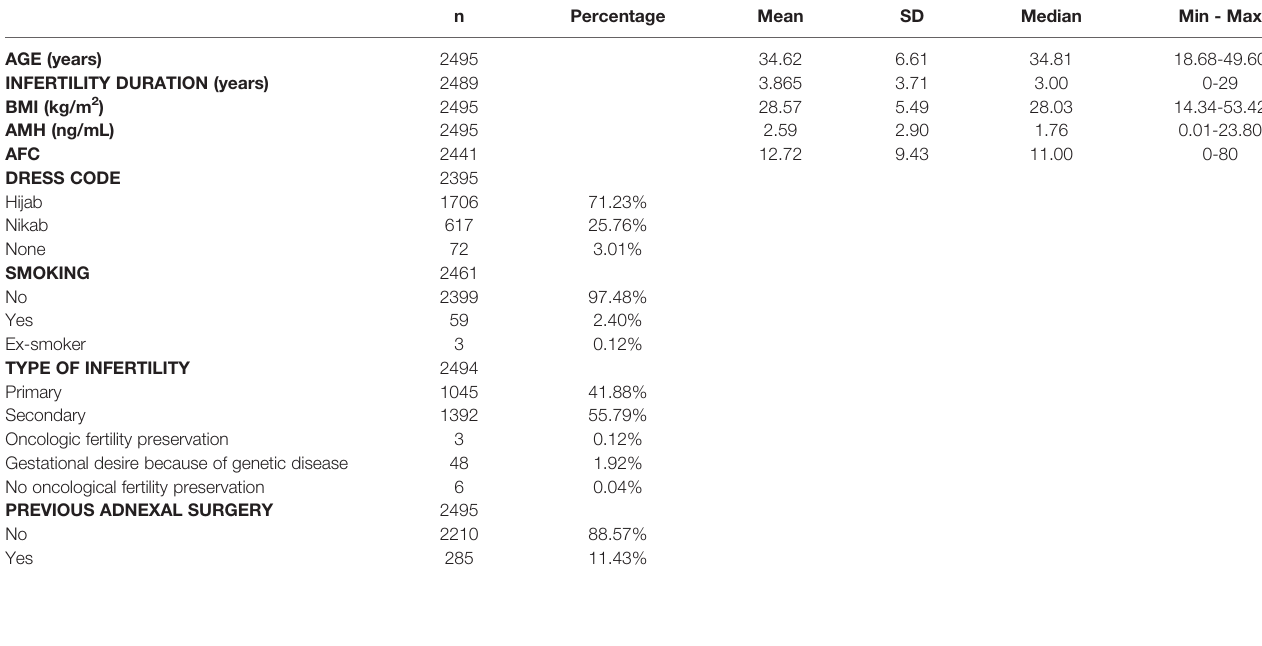
TABLE 1 | Demographic characteristics.